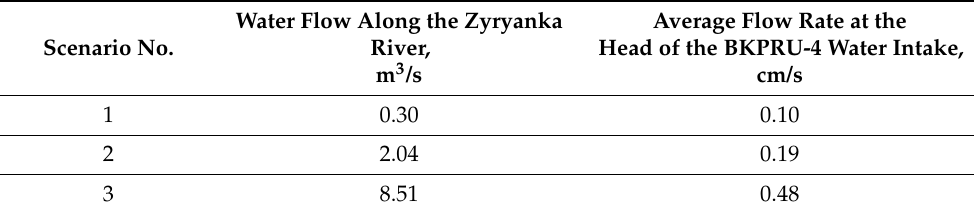
Figure 7. Calculated field of flow velocities in the water area of the Verkhne-Zyryansk reservoir in 2D formulation (scenario No. 3). Table 3. Calculated values of the average velocity in the area of the head of the BKPRU-4 water intake at the corresponding scenario water flow rates along the Zyryanka River. Two-dimensional simulation